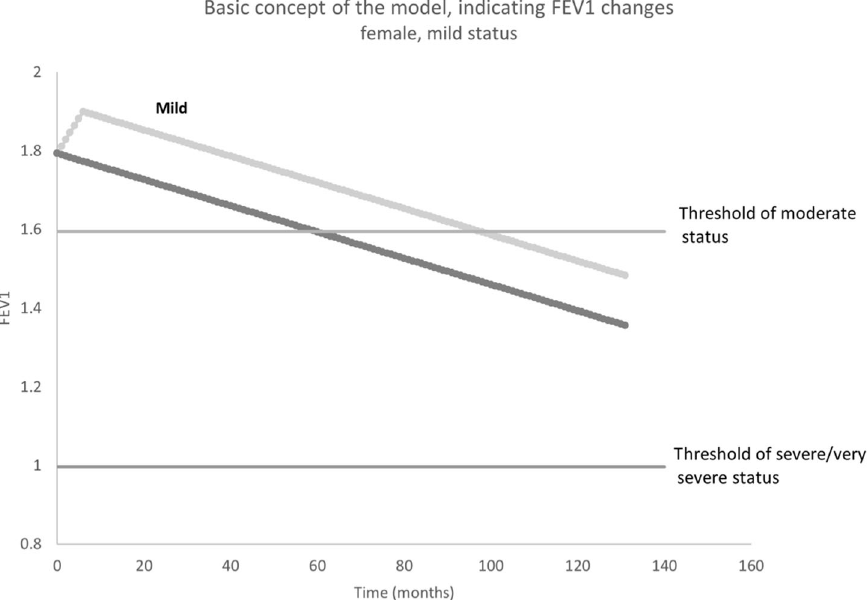
Fig. 5 Illustration for FEV1 changing among females in mild COPD status. Light gray line represented the detected mild population, while dark gray line represented the undetected mild